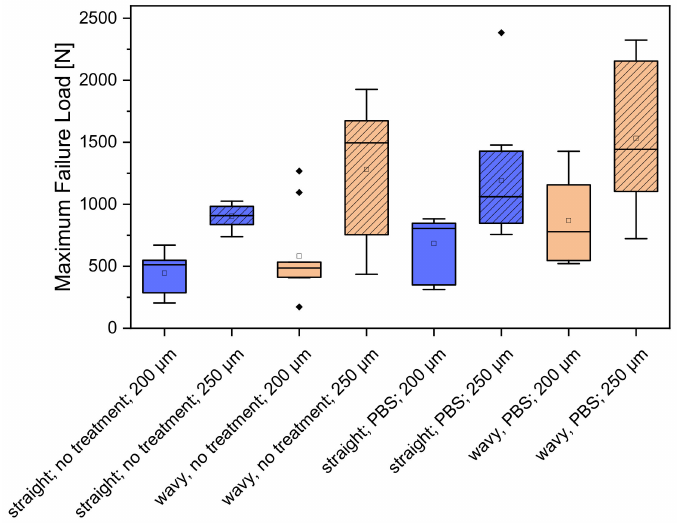
Figure 5. Overview of the maximum failure load for the different CPC scaffolds; n = 10.